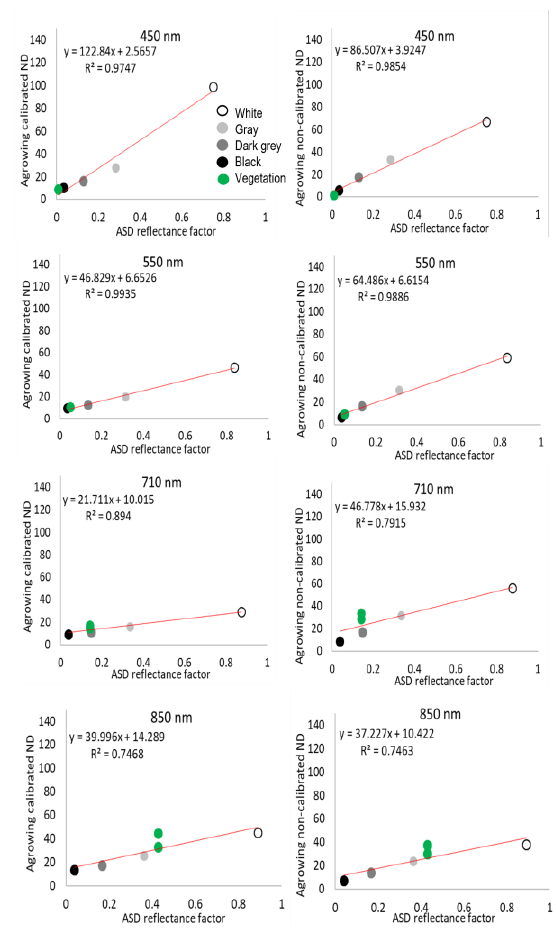
Figure 8. Scatterplots and adjusted lines between the ASD reflectance and Agrowing calibrated and non-calibrated digital number at 11:30 am acquisition.